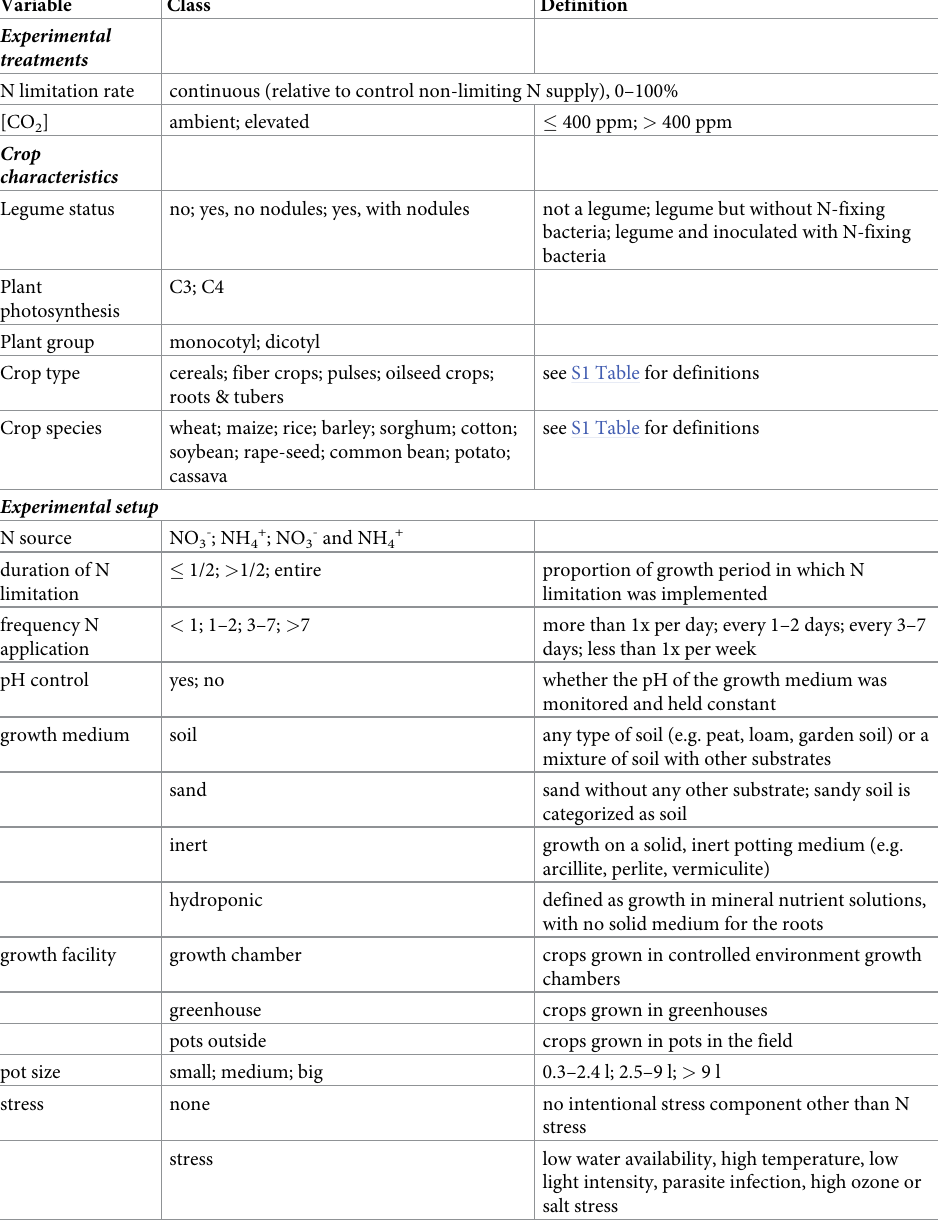
Table 2. List and definition of explanatory variables and their